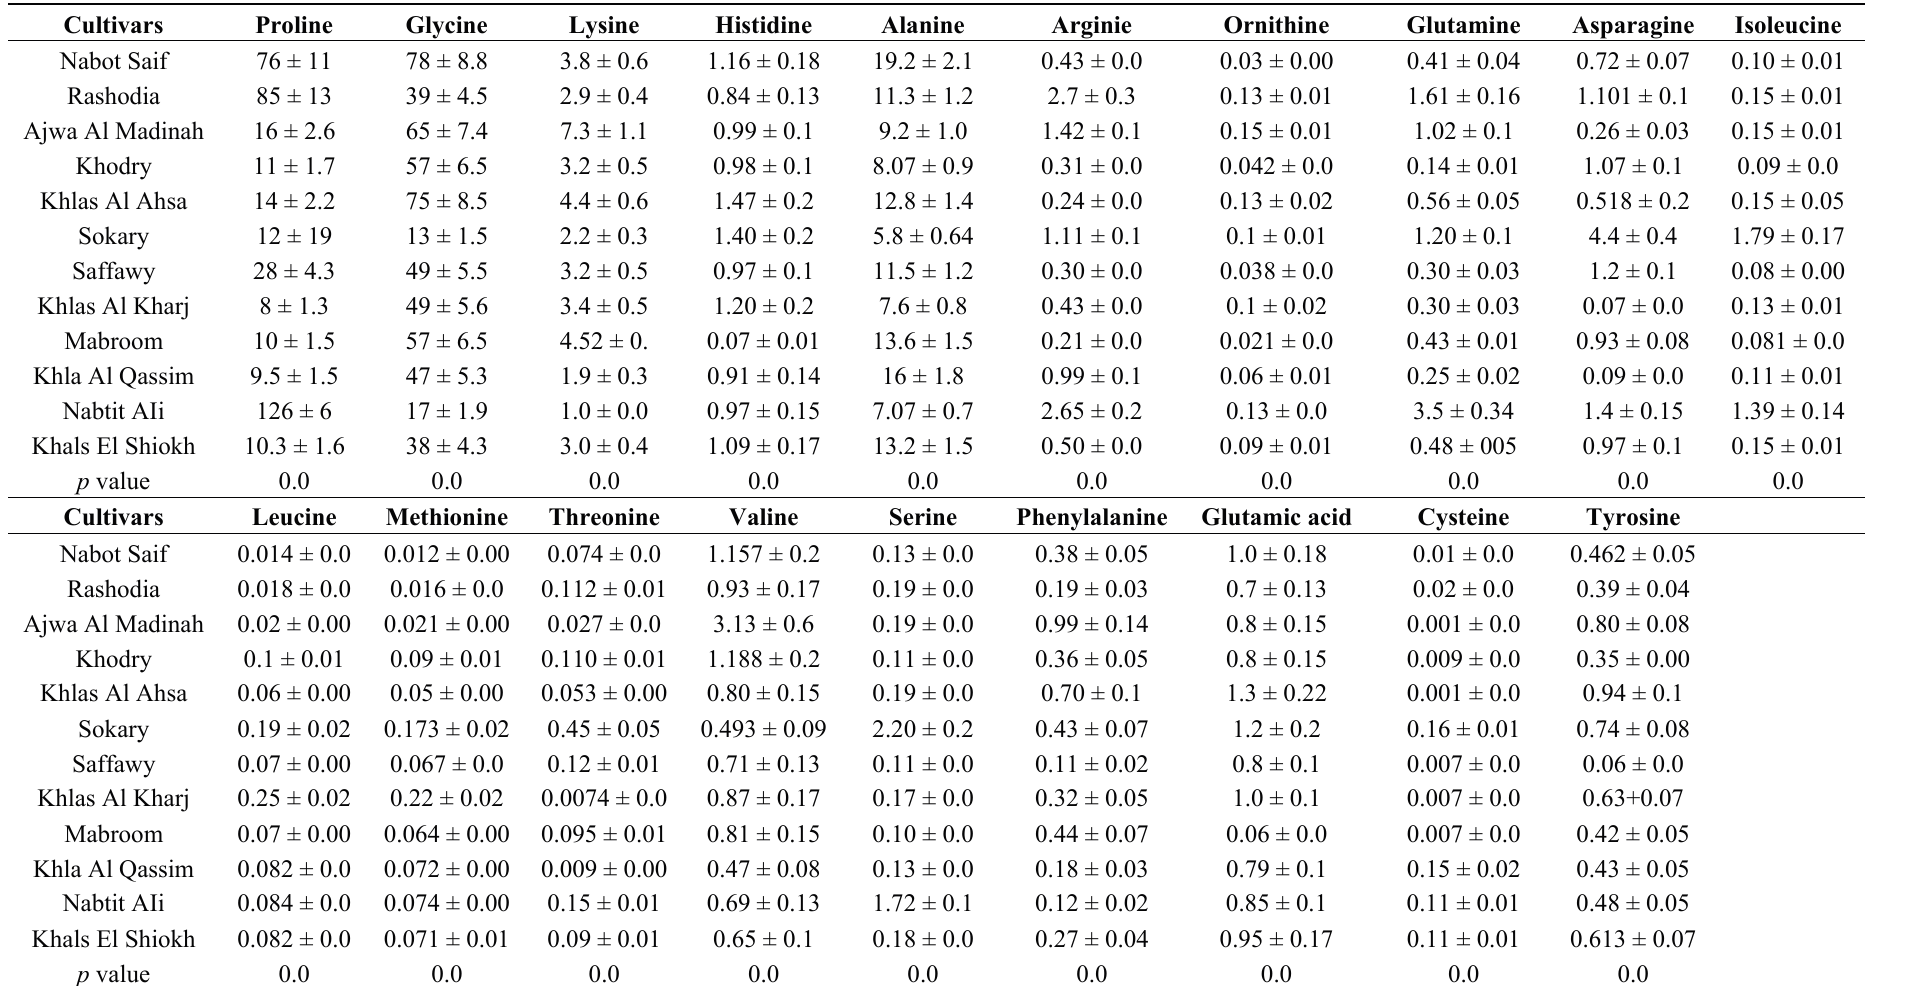
Table 2. Concentrations of amino acids ( μ mol·g − 1 FW) in 12 Saudi date